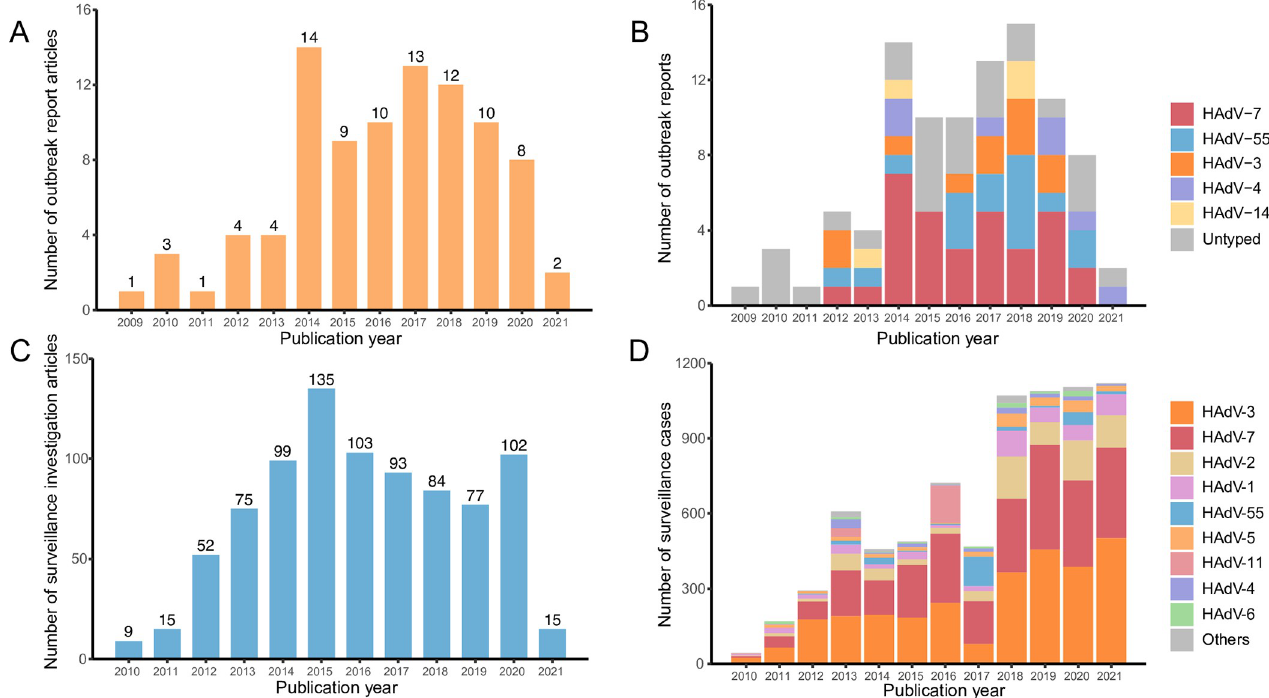
Fig 2. Temporal pattern of reported outbreaks and etiological surveillance as well as the HAdV types in China. (A) number of articles about reported outbreak events over publication year; (B) number of reported outbreaks according to each HAdV type group over publication year; (C) number of articles about etiological surveillance of HAdV over publication year; (D) number of patients reported in etiological surveillance according to each HAdV type group over publication year. Other in the panel D indicate those rarely seen HAdV types, including HAdV-21 (30 patients), HAdV-57 (18), HAdV-31 (5), HAdV-50 (2), HAdV-12 (1), HAdV-35 (1), and HAdV-104 (1). Deadline for literature search is March